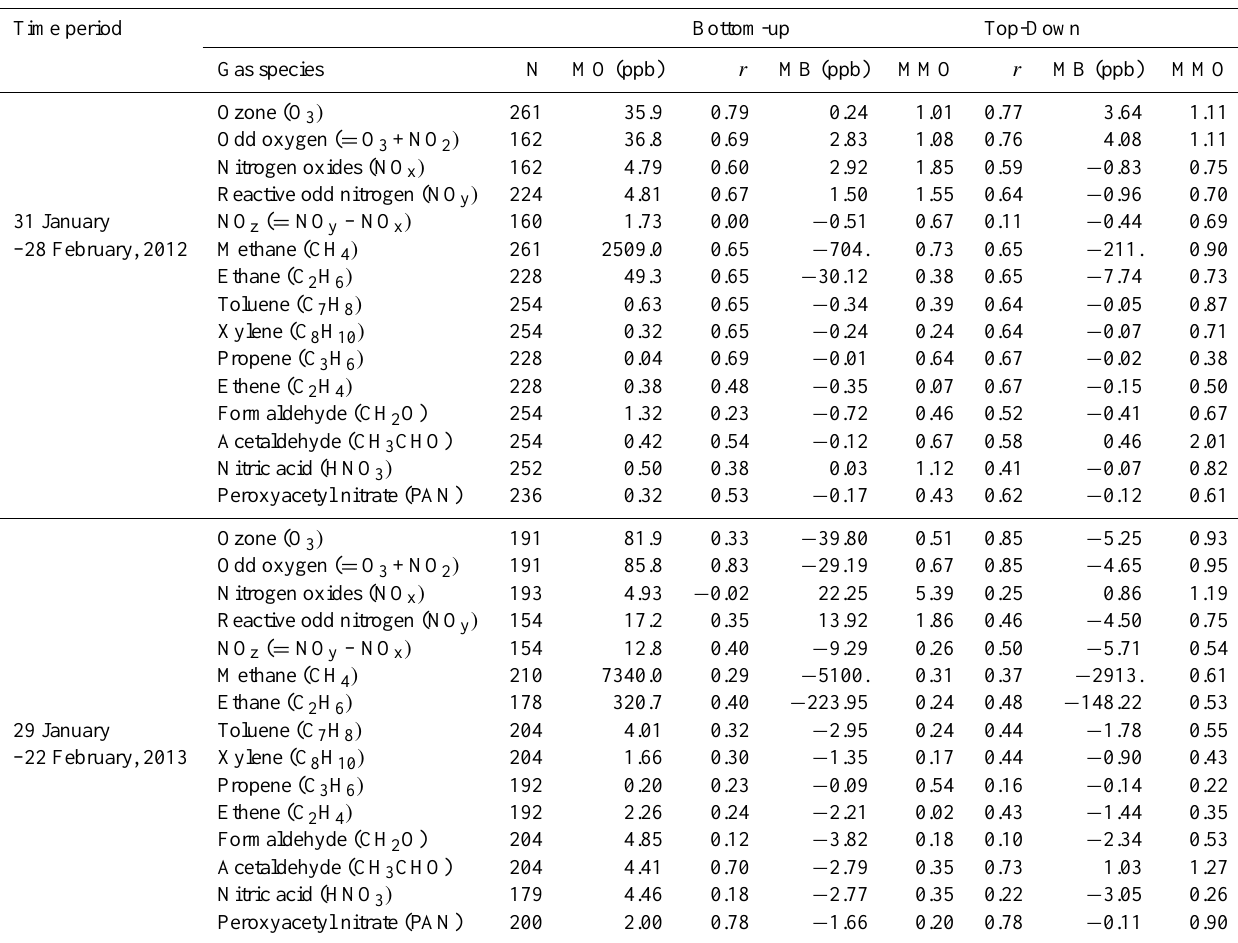
Table 3. Statistics for observed and simulated chemical species mixing ratios at Horse Pool, daytime 09:00–17:00 MST hourly average observations for the UBWOS 2012 and 2013 campaigns; N – number of used hourly observations, MO – median of observations, r - Pearson correlation coefficient, MB – median model-observation bias, MMO – median of model over